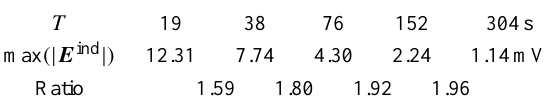
Dependence of max ( | E ind | ) on the duration T of the electrojet intensification. In these examples T is changed by a factor of 2 while keeping all other parameters fixed. Also the ratio between the maximum values of E ind for different T is